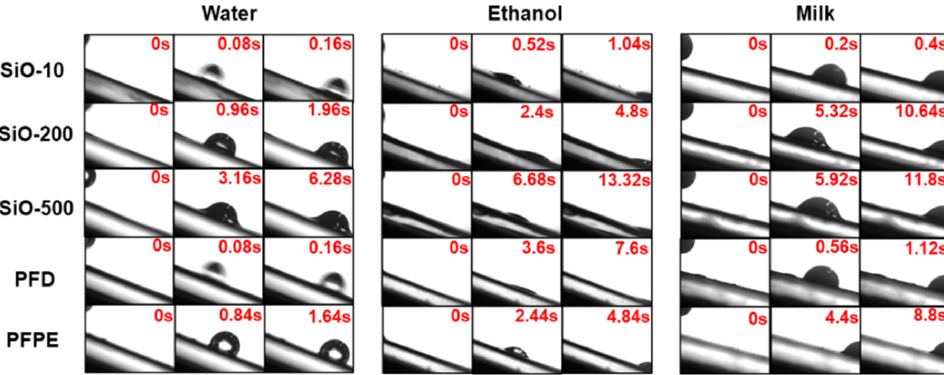
Figure 4. Sliding process and time spent for three liquids (water, ethanol, and milk) on the lubricant-infused samples.